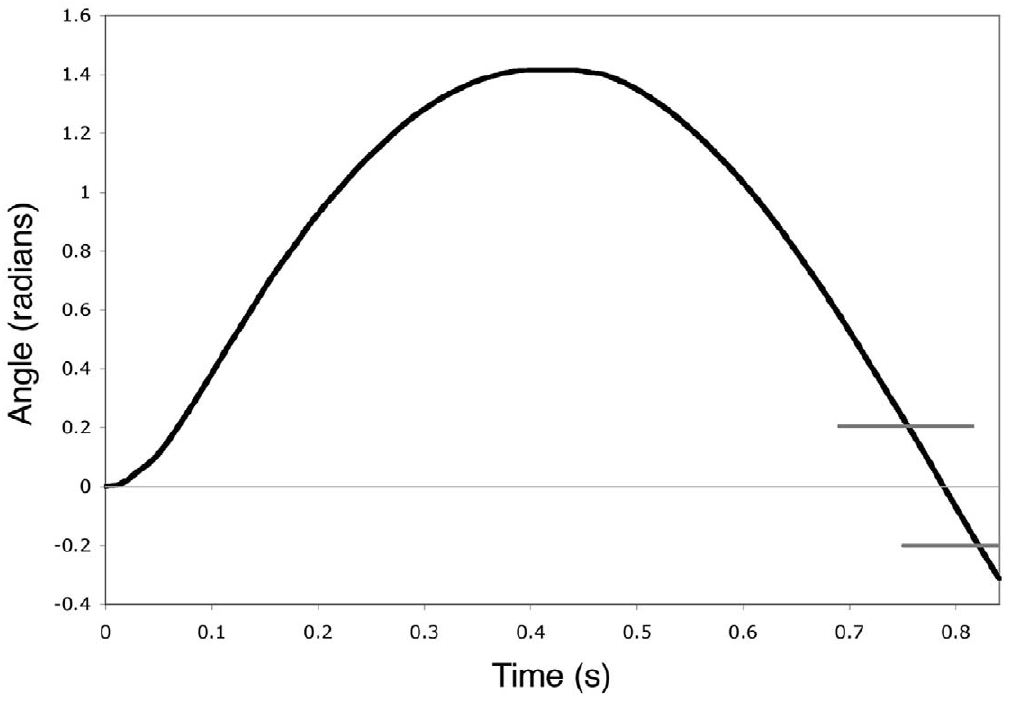
Figure 3. Sample recording of the energy delivered in maximum effort downward and upward directed strikes. Contact with the transducer was made at time zero. The force of the strike caused the pendulum to swing upward. Maximum potential energy occurred at the peak of the curve. Maximum kinetic energy occurred as the pendulum swung back to the bottom of its arch at 0 radians. To calculate the maximum kinetic energy of the pendulum, the angular velocity ( v ) of the pendulum was measured as it swung through the bottom of its arc, over an angular displacement of + 0.20 to 2 0.20 radians, indicated by the horizontal grey lines.